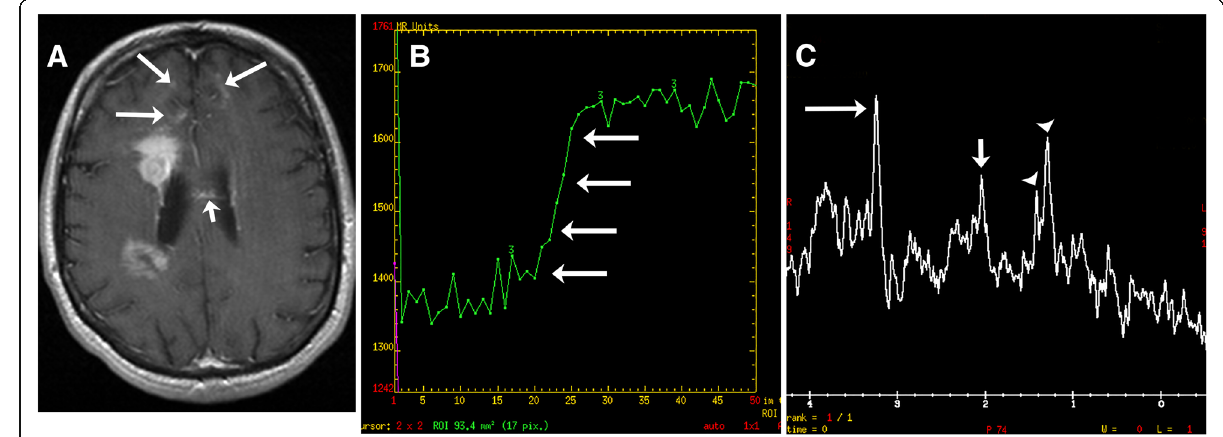
Fig. 5 Primary central nervous system lymphoma. T1-weighted image with gadolinium ( a ) shows two lesions with intense enhancement along the right lateral ventricle. Also, note the frontal subcortical enhancement (long arrows) and linear enhancement in the corpus callosum (short arrow). Perfusion curve ( b ) shows increasing signal without the expected signal drop on echo-planar T2* perfusion due to gadolinium leaking thru a disrupted blood-brain barrier (arrows). Single voxel spectroscopy (TE = 35) ( c ) demonstrates elevated choline (long arrow) due to increased cellularity, decreased NAA (short arrow), and presence of lipid/lactate (arrowheads). No creatine peak is